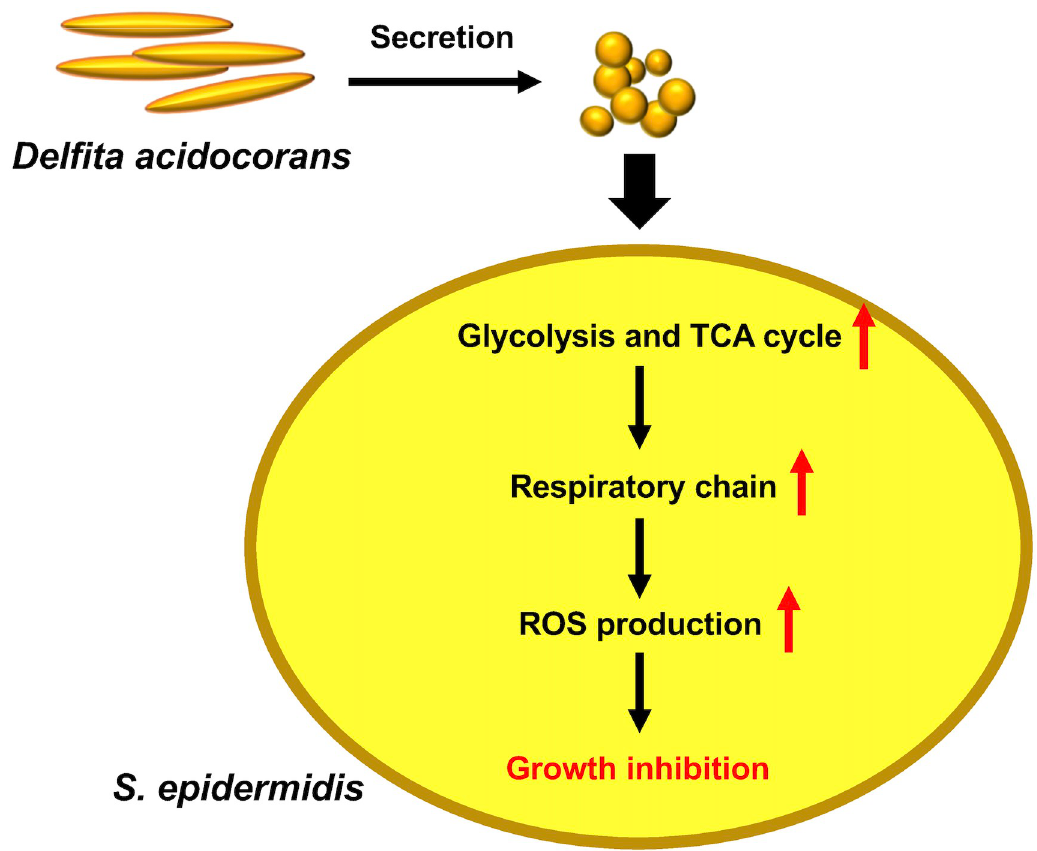
Fig 7. Model of the action of heat-stable substances secreted by D . acidovorans against S . epidermidis . Heat-stable substances secreted by D . acidovorans induce the expression of the genes related to glycolysis and the TCA cycle and subsequently increase ROS production in S . epidermidis . The induced ROS production leads to growth inhibition in S . epidermidis